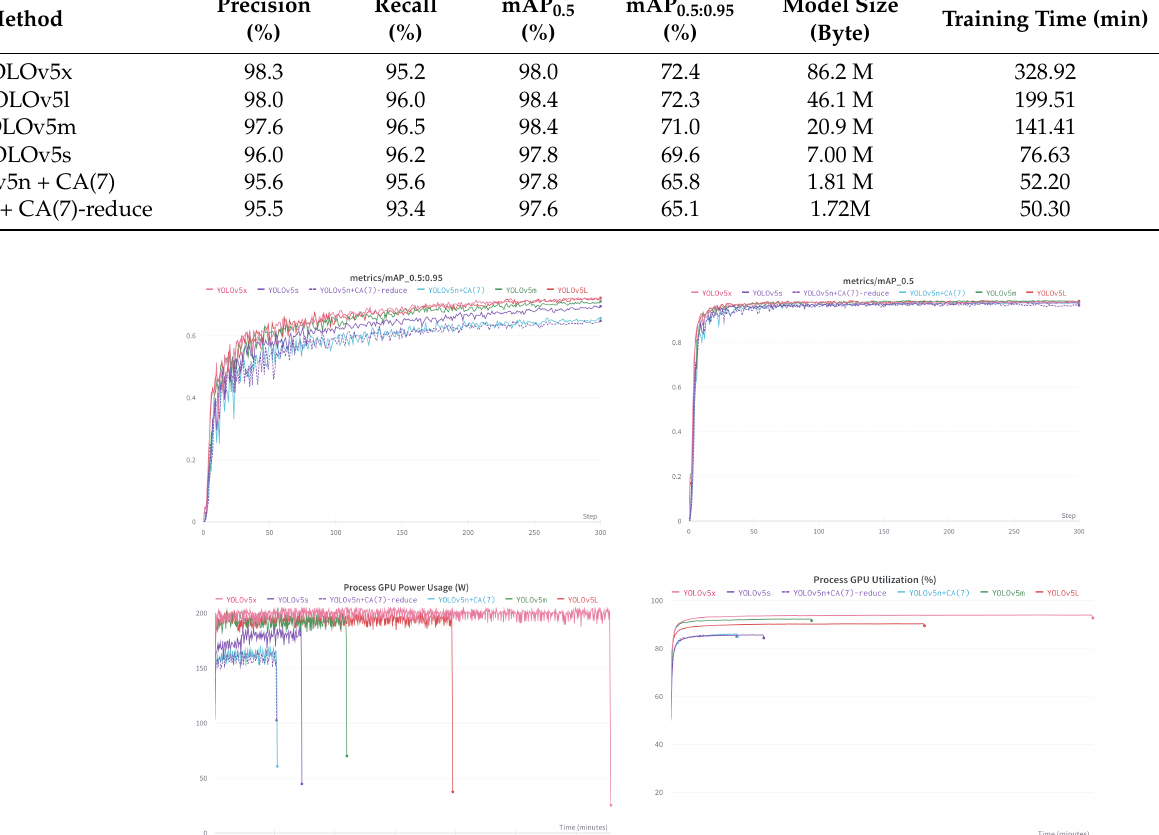
Figure 10. The upper left and upper right subplots give the scores of different models at IOU = 0.5:0.95 and IOU = 0.5, and the lower left and lower right subplots give the process GPU power usage and process GPU utilization of different models,